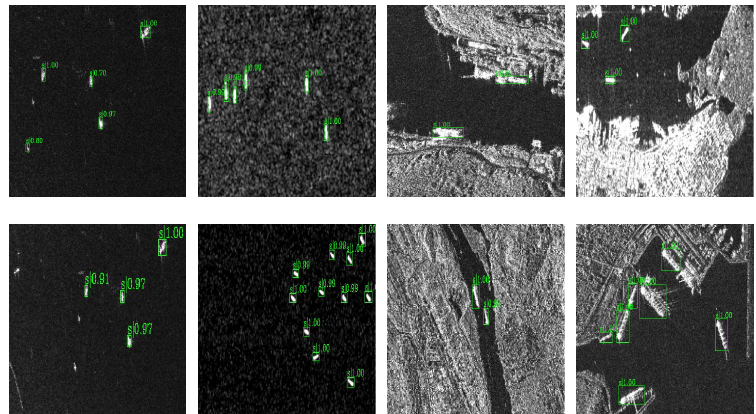
Figure 16. Some of the detection results obtained by the proposed overall framework on